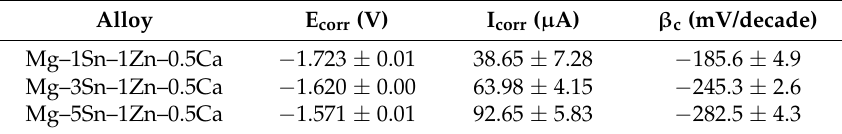
Figure 8. Polarization curves and Electrochemical Impedance Spectroscopy spectra of hot-rolled Mg − xSn − 1Zn − 0.5Ca (x = 1, 3 and 5 wt.%) alloys in Hank’s solution: ( a ) Polarization curves; ( b ) Nyquist plots; ( c ) Bode plots; ( d ) equivalent circuit. Table 4. Fitted results from polarization Table 4. Fitted results from polarization curves.